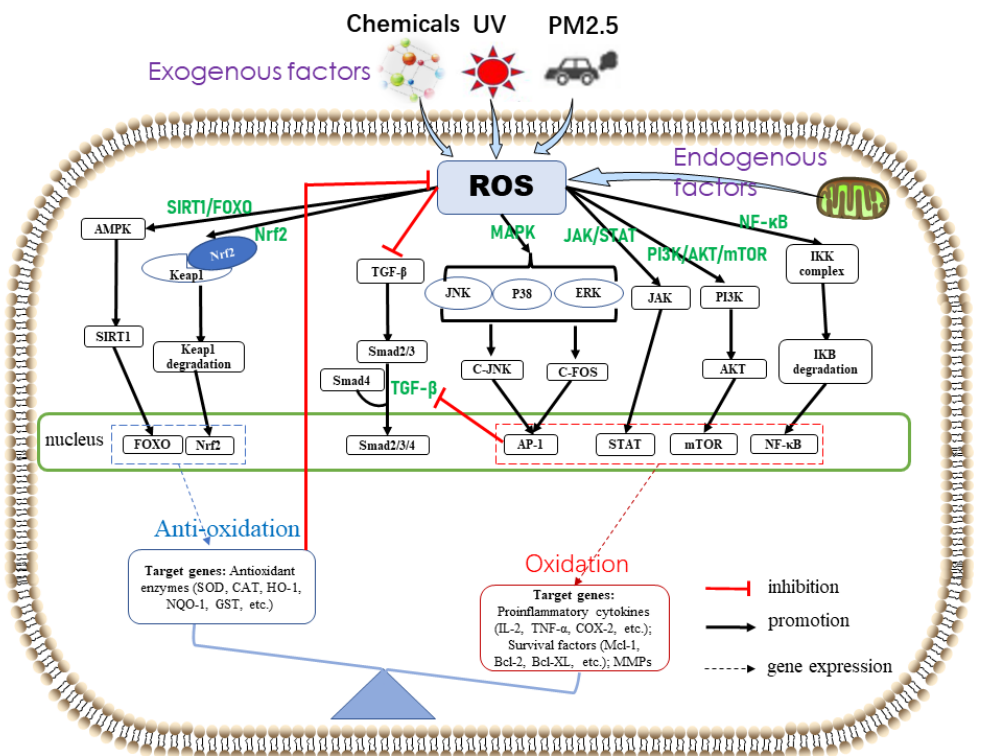
Figure 2. Skin oxidative stress-related signaling pathways. Exogenous stimuli (e.g., UV, chemicals, and PM2.5) and/or endogenous factors (e.g., mitochondrial oxidase and metabolism) induce ROS overproduction. ROS activate the antioxidant defense system and promote the expression of antioxidant enzymes through Nrf2 and SIRT1/FOXO pathways, which in turn reduce ROS production. When the antioxidant defense system fails to completely scavenge ROS, oxidative stress is induced. Excessive ROS activate MAPK, JAK/STAT, PI3K/AKT/mTOR, and NF- κ B signaling pathways, thereby resulting in the expression of cytokines associated with skin cellular senescence, inflammation, and cancer. The transforming growth factor- β signaling pathway, related to collagen synthesis, is inhibited by ROS and the transcription factor AP-1 to accelerate skin cellular senescence.